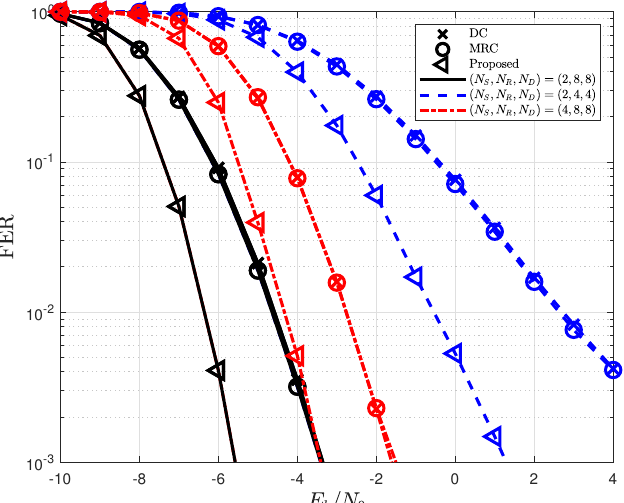
Figure 7. Impact of the number of antenna configurations ( N S , N R , N D ) on the proposed detection.